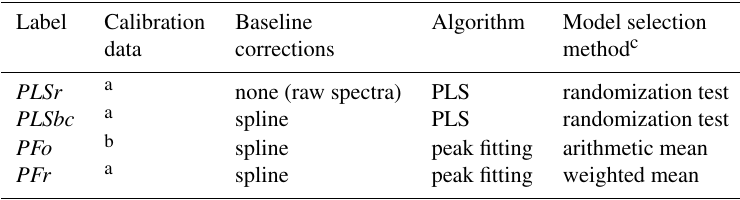
Table 1. Summary of models evaluated.